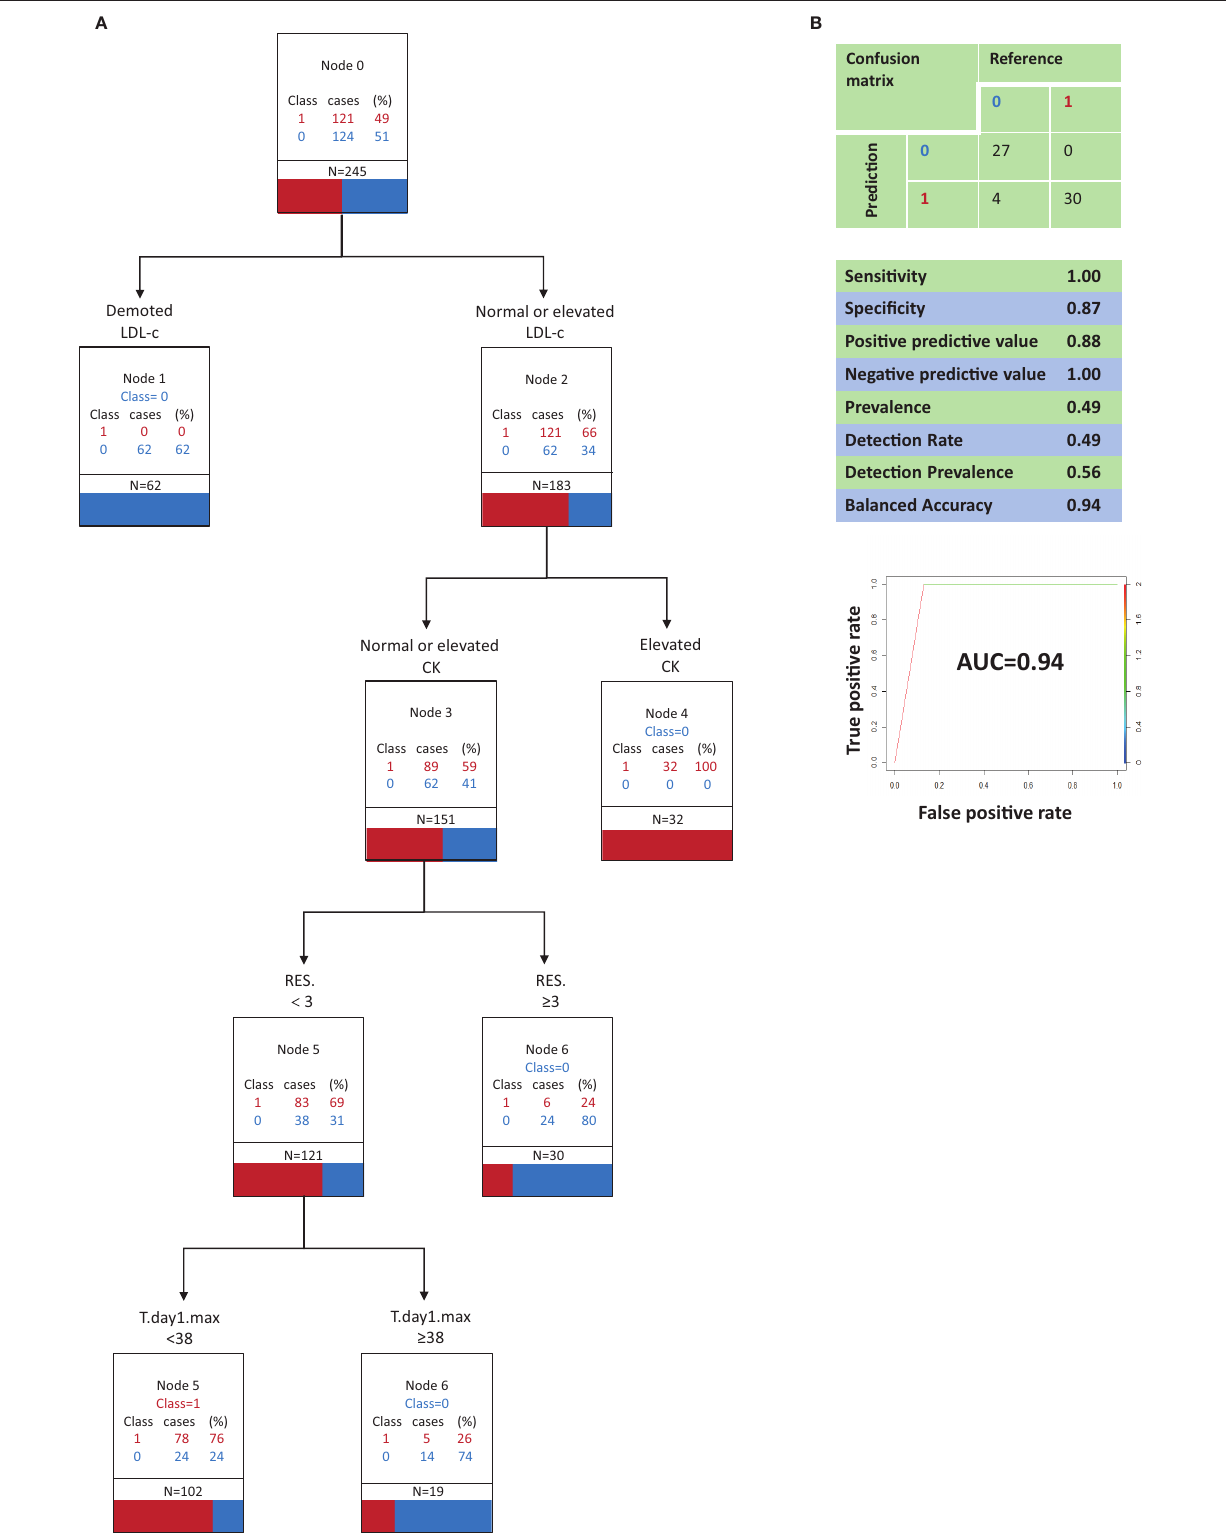
FIGURE 2 | Classification and regression tree analysis of variables that most distinguish COVID-19 from Influenza A in clinical signs and symptoms and in serum biochemistry (model A, optimal model). (A) 0, Influenza A; 1, COVID-19; N, the total number of patients; RES., The number of respiratory symptoms; T.day1.max, Highest temperature on the first day of admission; LDL-c, Low-density lipoprotein cholesterol; CK, creatine kinase. All factors are compared with the limit of the range of medical reference value. (B) Performance characteristics of the model validated by the testing set. Frontiers in Medicine |